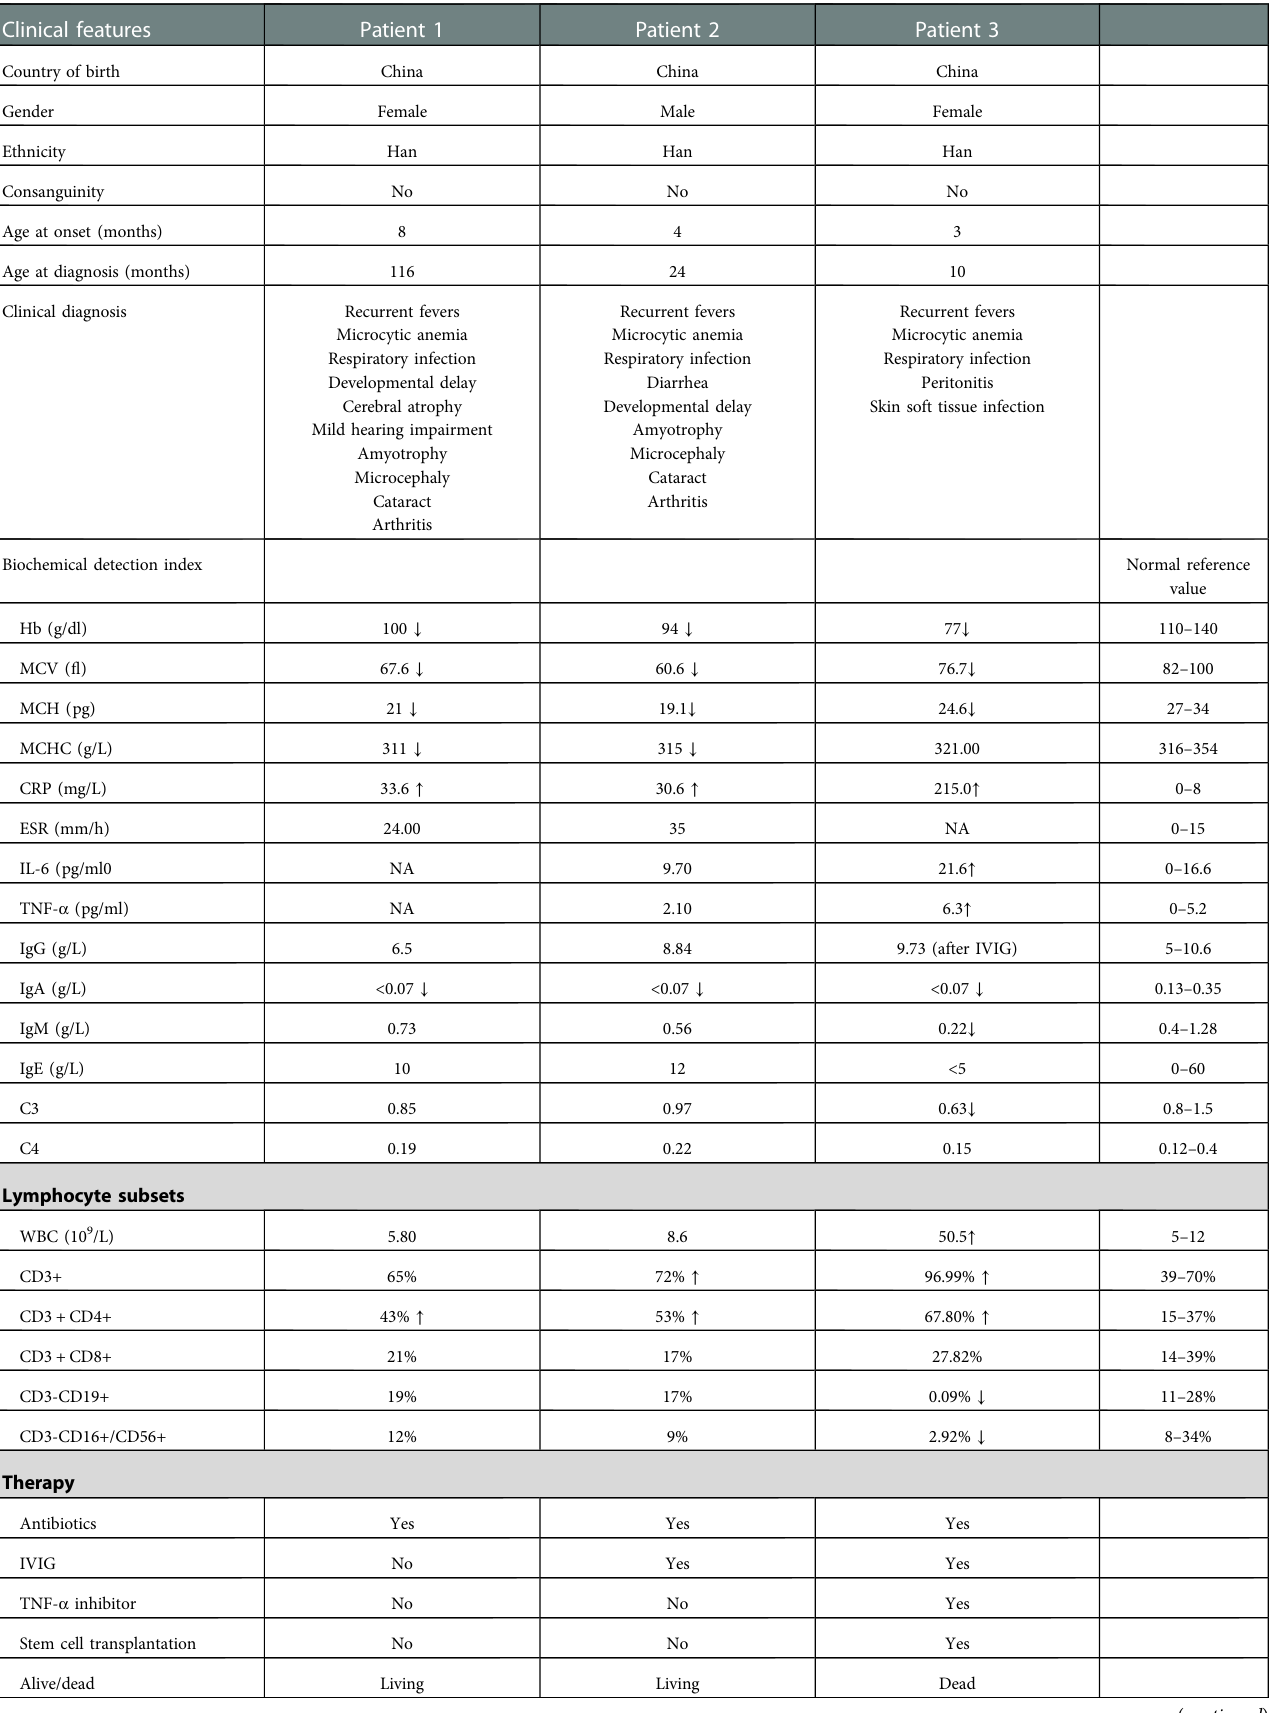
TABLE 1 Clinical features, biochemical detection index, and genetic analysis of SIFD patients ( n